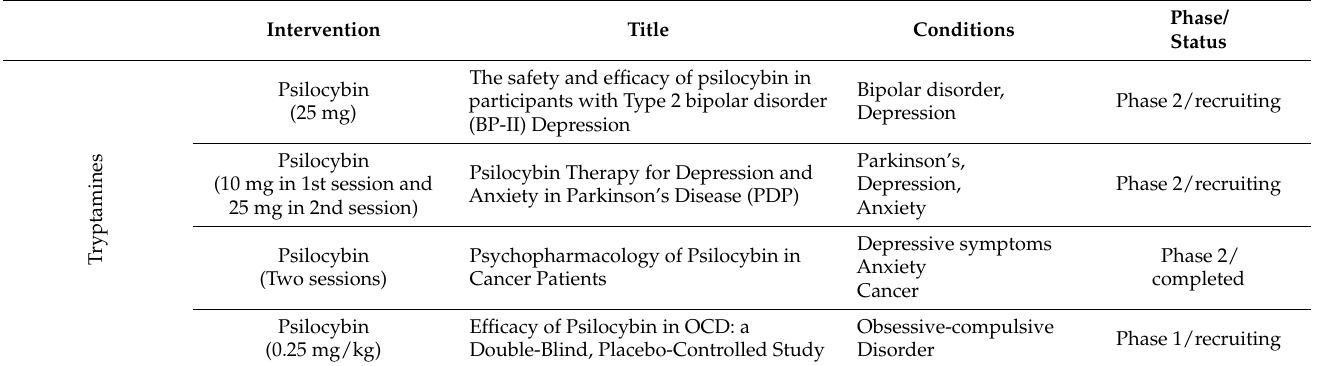
Table 6. Selected examples of ongoing clinical trials involving indole alkaloids and neuropsychiatric disorders (registered on the ClinicalTrials.gov accessed on 10 October